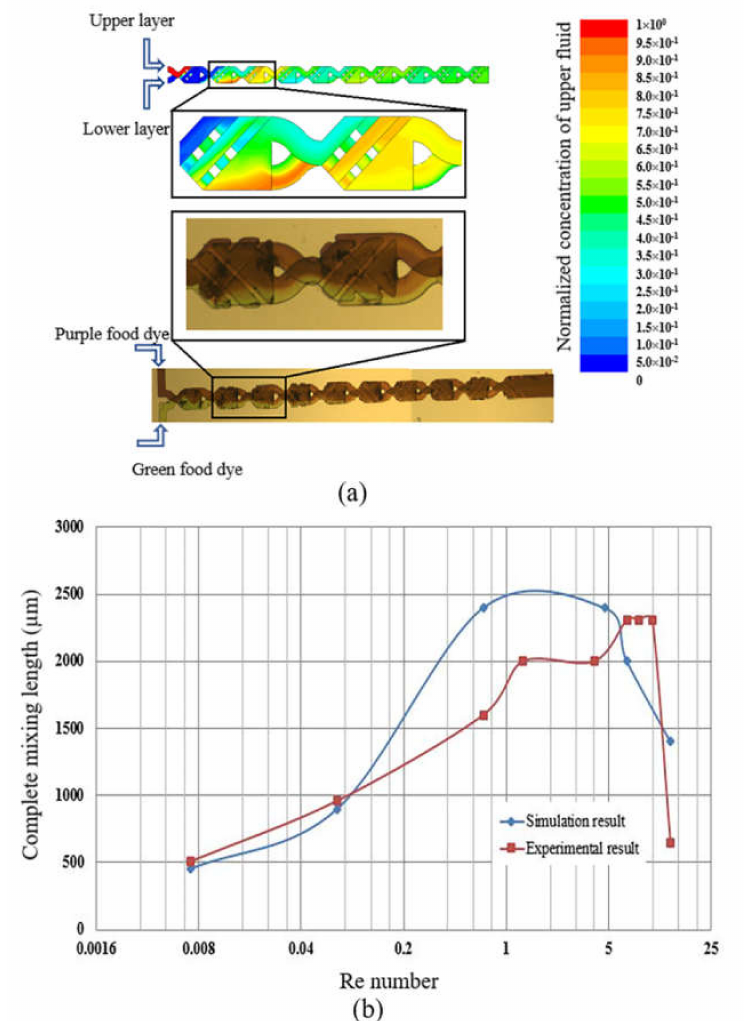
Figure 8. ( a ) Comparison of experimental and simulation results at a flow rate of 3 µ L/min; ( b ) Com- parison the trend of curve of complete mixing lengths between experimental and simulation results in the micromixer at variation of Re